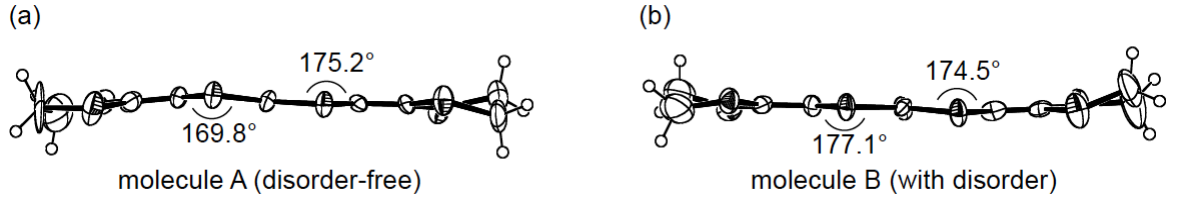
Figure 17. Side views of the structures of molecules ( a ) A and ( b ) B in α-(DHOT-TTP) (AuI ) 2 2 0.87